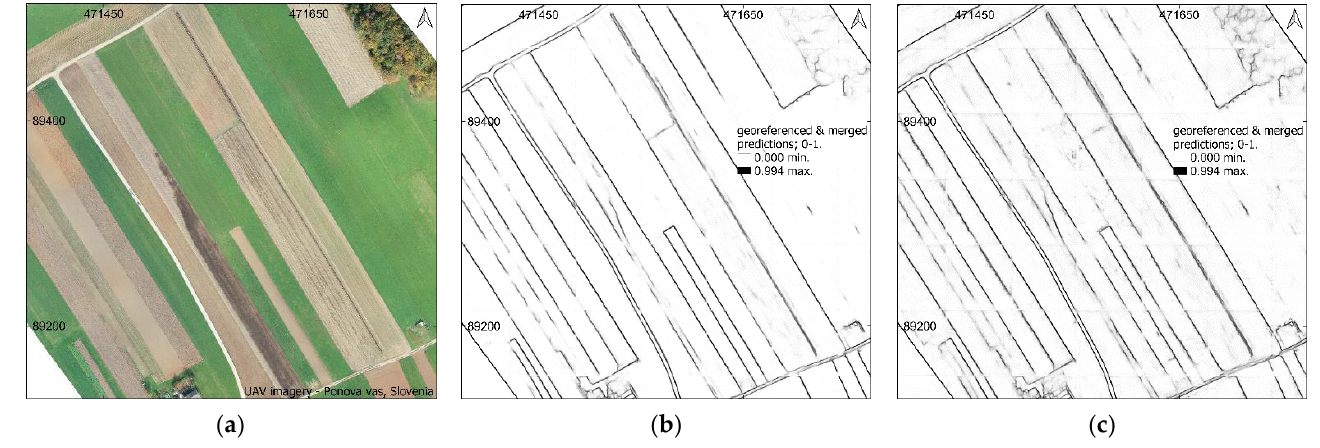
Figure 5. Georeferenced and merged boundary maps for the test area in ( a ) Ponova vas, Slovenia. Predicted boundary map with ( b ) customised CNN, and ( c ) original U-Net architecture.